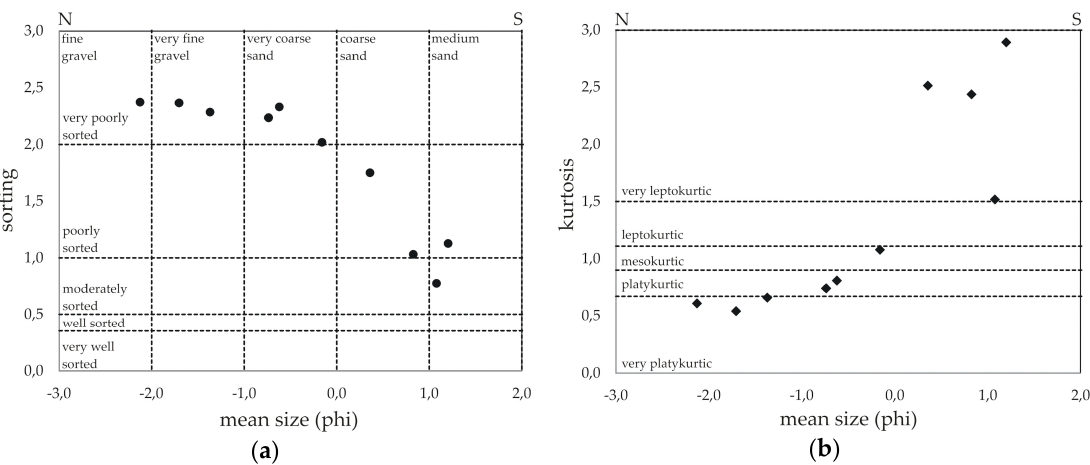
Figure 8. Relationships between grain size parameters along the A-A’ profile. ( a ) Mean size vs. sorting; and ( b ) mean size vs. kurtosis.